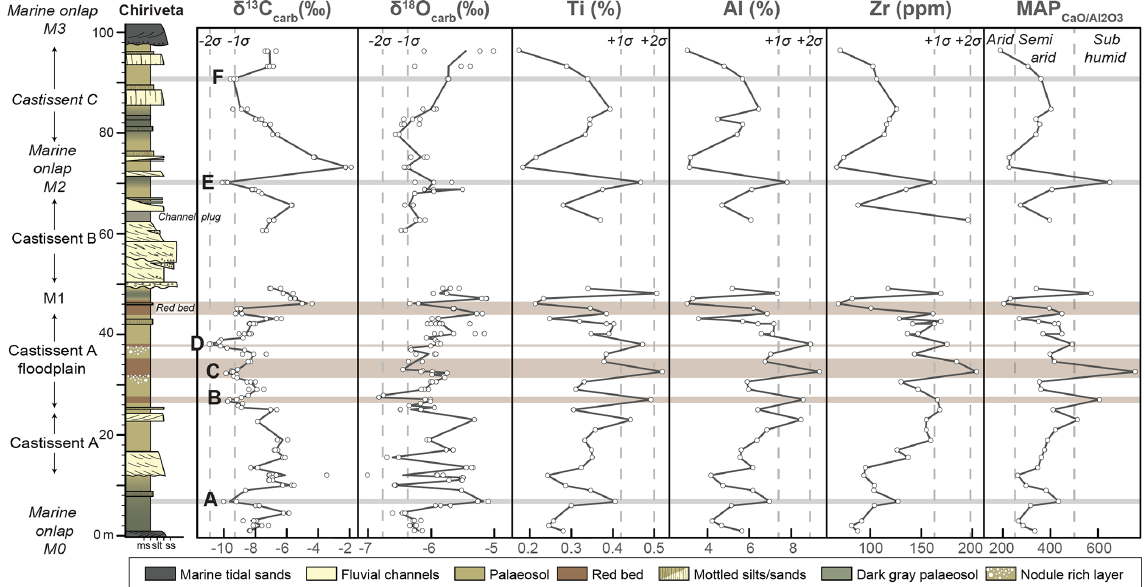
Figure 5. Isotopic and geochemical data from the Chiriveta section. For the isotope dataset, the curves passes through the mean values at each sample position. Samples with minimum in δ 13 C values below 1 and 2 standard deviations are labelled A to F. Mean annual precipitation (MAP) was estimated from the empirical relationship between MAP and CaO to Al 2 O 3 ratio (Sheldon et al., 2002).